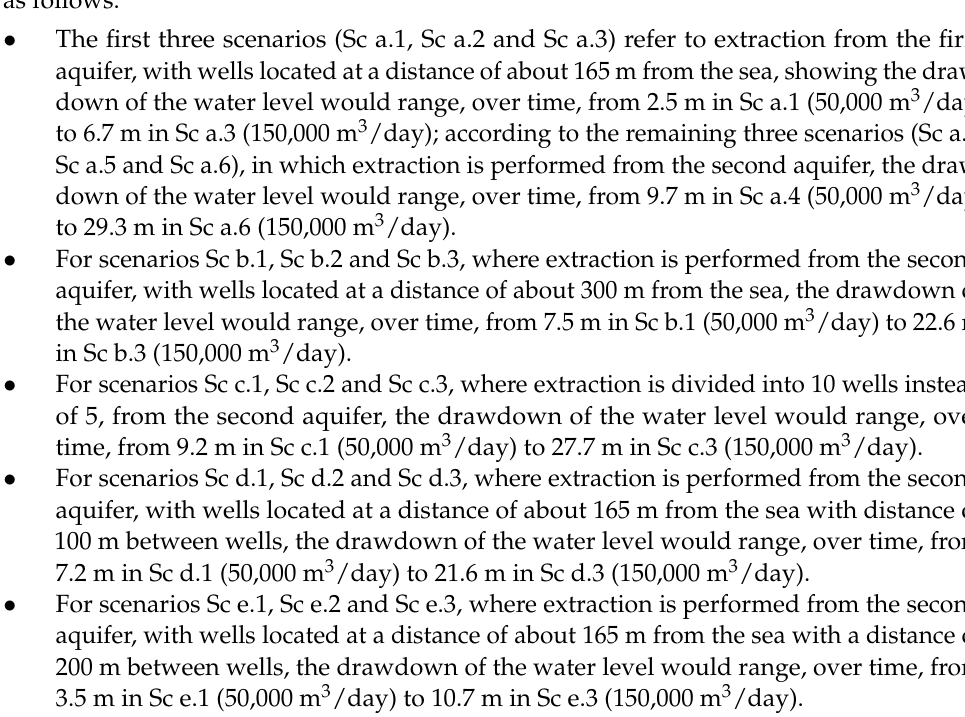
Table 3. Summary of testing